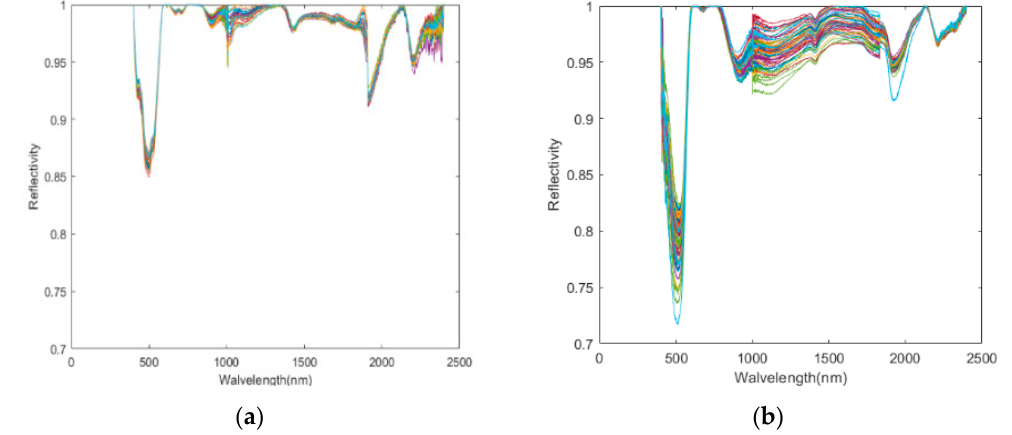
Figure 4. Spectral reflectance curve of soil sample after the removal of the noise edge wavelengths and the CR: ( a ) Honghu; ( b ) Daye.